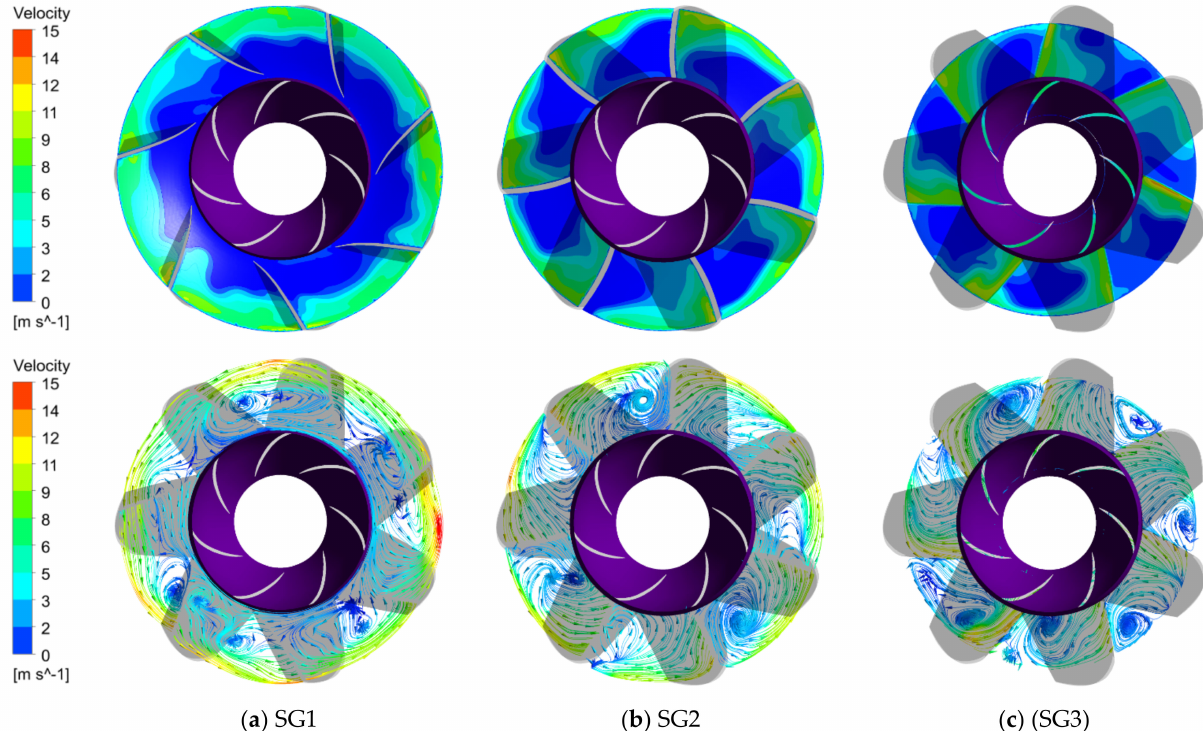
Figure 13. Flow axial velocity contours and streamlines within the diffuser under 0.65 Q BEP flow conditions for different positions along the streamwise